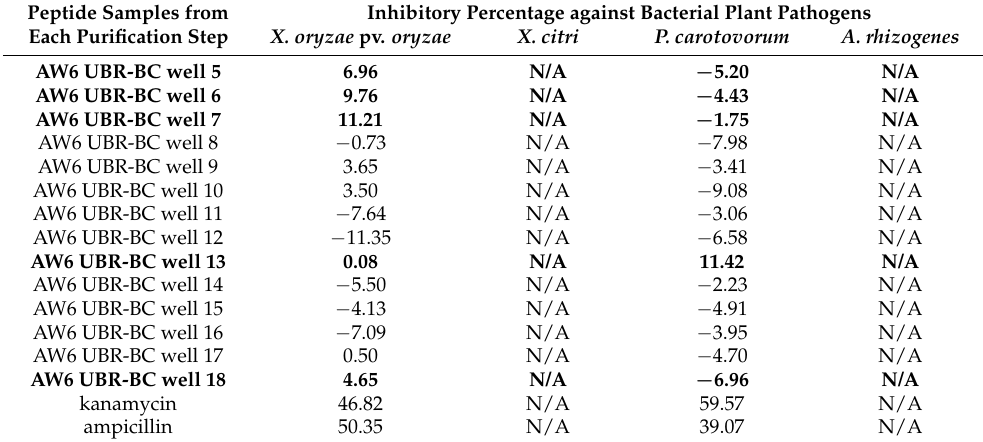
Table 4. Cont. Peptide Samples from Inhibitory Percentage against Bacterial Plant Pathogens X. oryzae pv. Each Purification Step